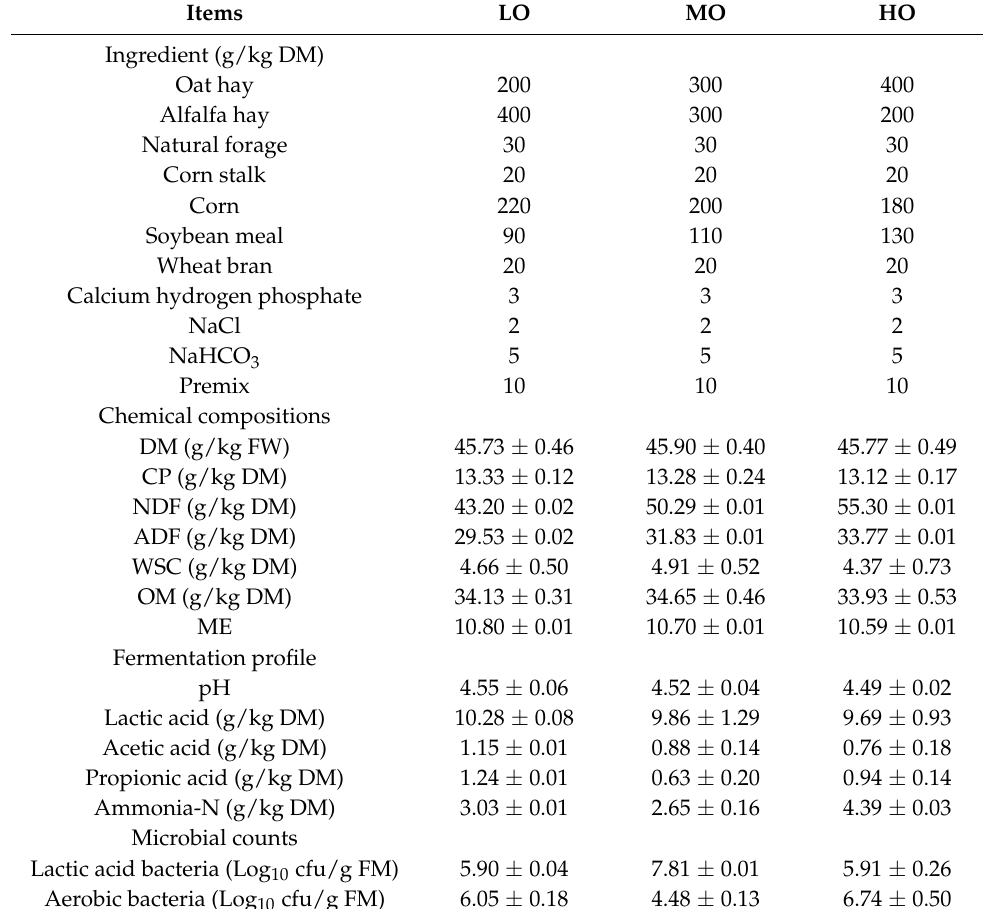
Table 1. Ingredients and chemical composition of dietary. Items LO